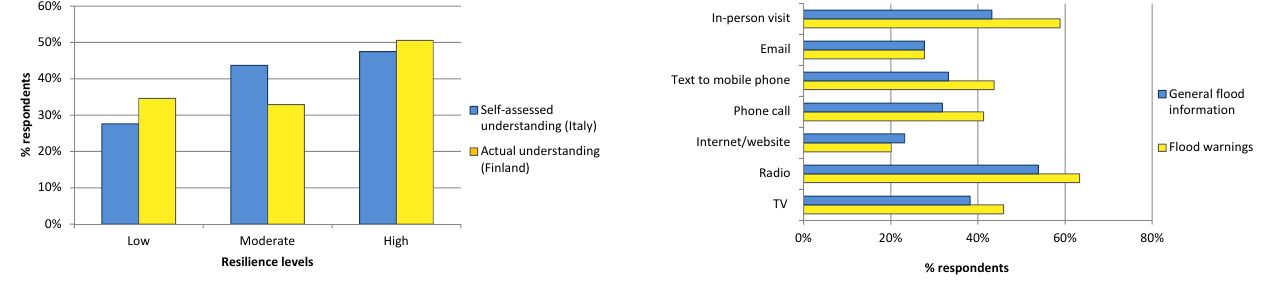
Fig. 7. Preferred communication methods for receiving flood in- formation and warnings in Finland, Ireland and Scotland ( n = 906; non-response =